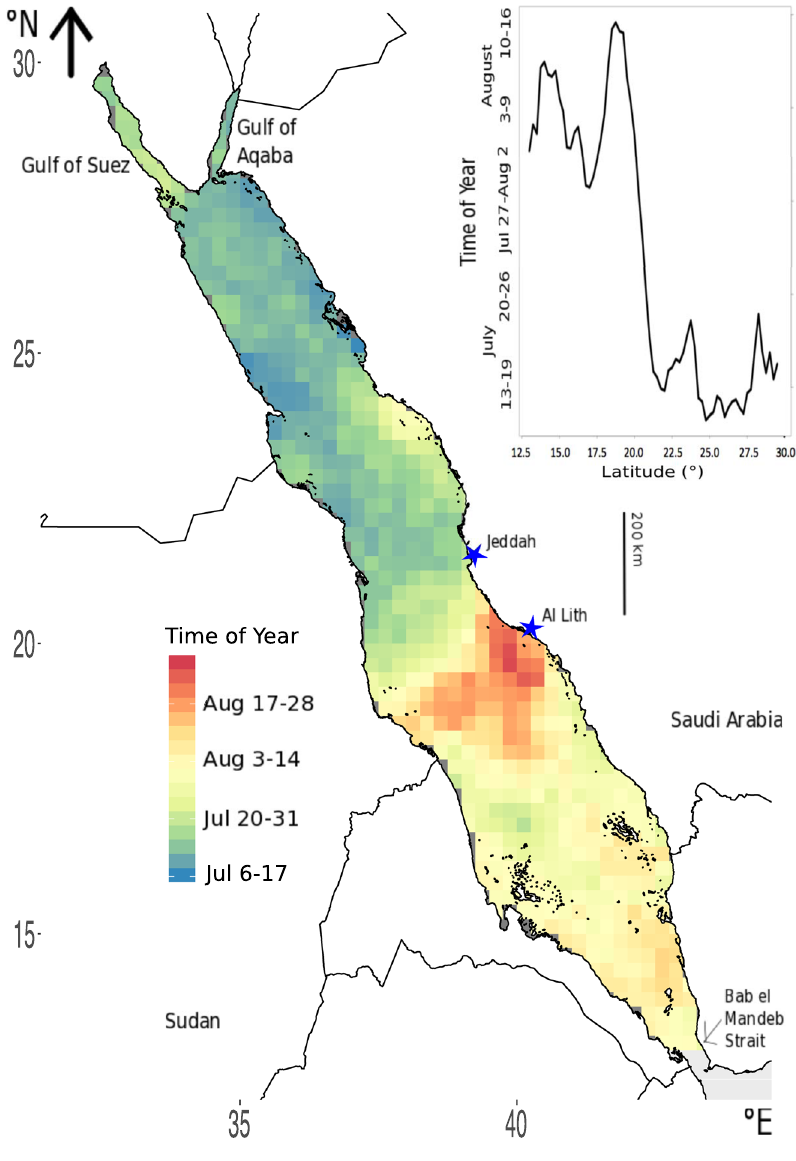
Figure 2. Average yearly timing of maximum annual temperature (T max ) across the Red Sea. Insert shows the latitudinal trend in the average timing of T max . Image created using R (v3.3.1, www.R-project.org) 45 including packages: ggplot2 46 and rasterVis 47 , RStudio (v1.0.143, www.rstudio.com), and InkScape (v0.91,